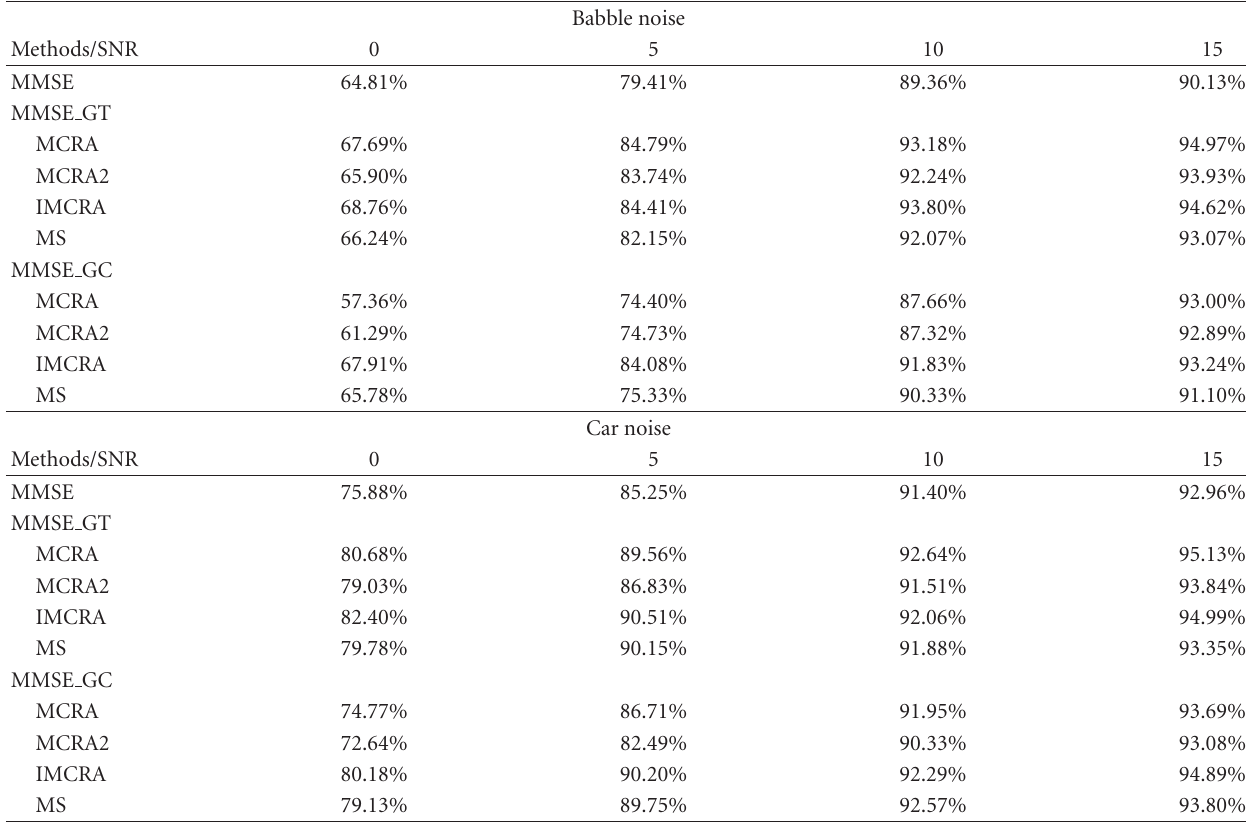
Table 3: Recognition rate for the proposed perceptual generalized spectral subtraction method based on the gammatone and the gammachirp filter banks decomposition (MMSE GT and MMSE GC) compared with the spectral modification rule